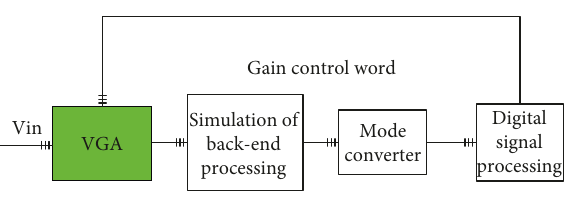
Figure 5: Digital automatic gain control circuit.